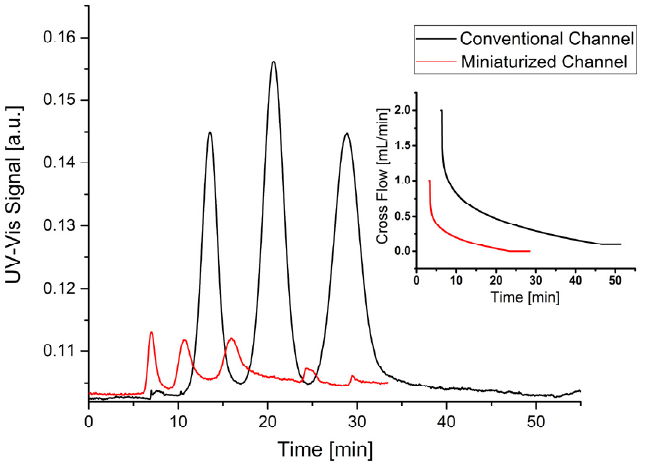
Figure 4. Comparison of fractograms of mixtures of gold nanoparticles in a conventional (black line, gold nanoparticle mixture I) and a miniaturized AF4 channel (red line, gold nanoparticlemixture II, sample dilution 1:8) at previously optimized conditions. Insert shows cross flow profile, UV-Vis detector. Table 7. Comparison of chromatographic parameters of a gold nanoparticle mixture obtained with both channels (single measurement).